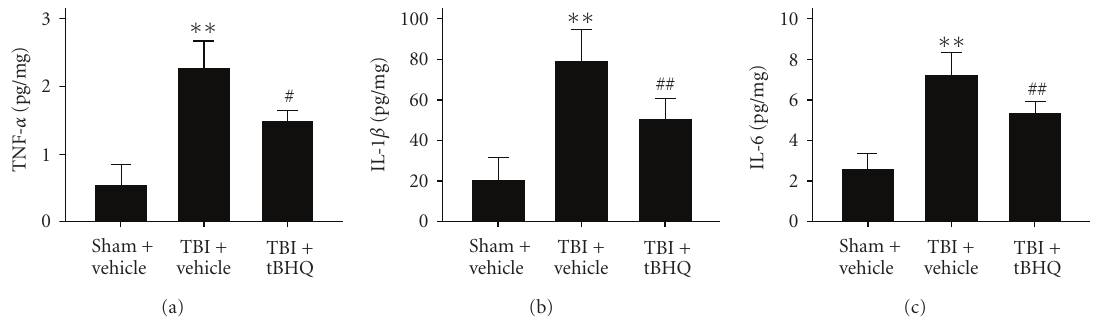
Figure 2: Concentrations of inflammatory cytokines in the intestinal tissue in sham + vehicle group, TBI + vehicle group, and TBI + tBHQ group ( n = 6). The figure indicates that concentrations of TNF- α , IL-1 β , and IL-6 in the intestine were significantly increased after TBI and could be suppressed when treated with tBHQ. ∗∗ P < . 01 versus sham + vehicle group. # P < . 05 and ## P < . 01 versus TBI + vehicle group.